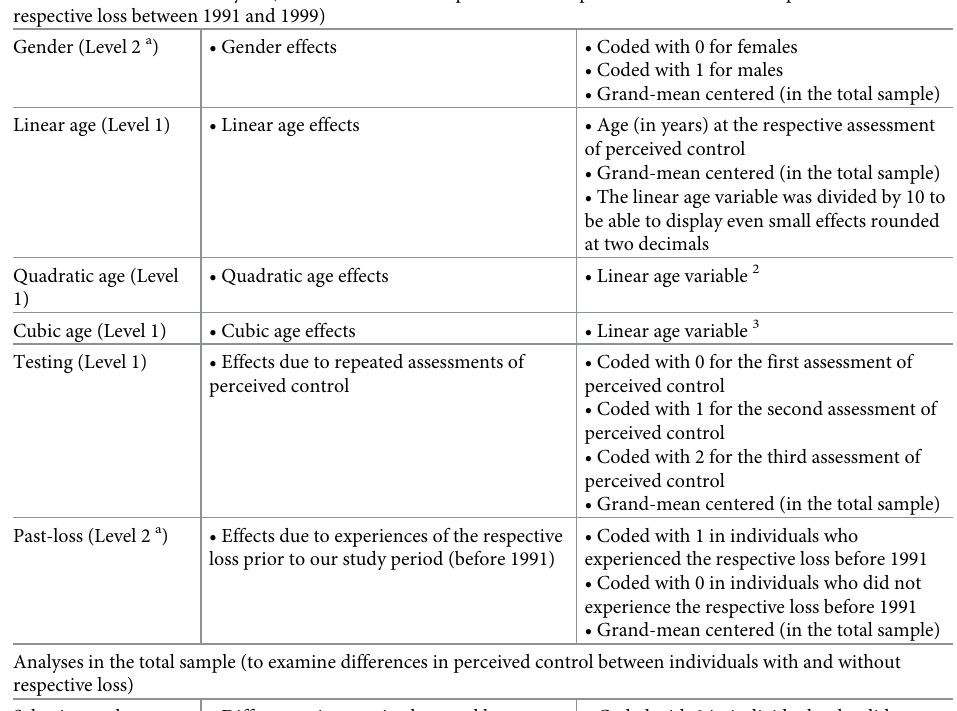
Table 1. Description and coding of the included